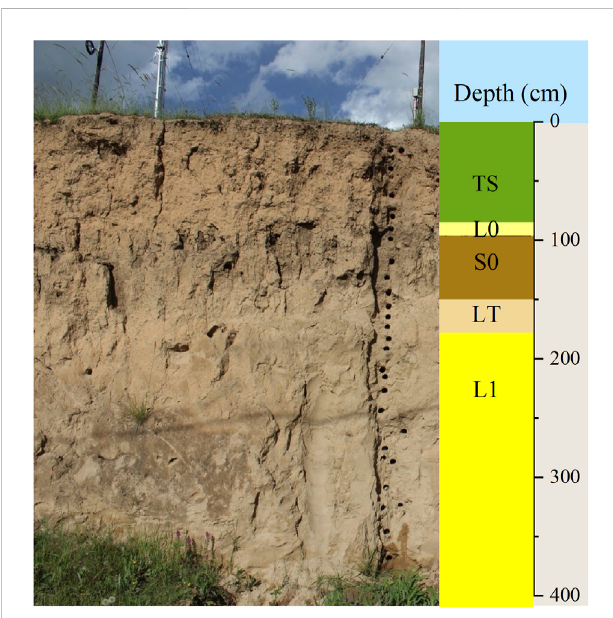
Scheme of the YHC loess-paleosol sequence. The abbreviation of the different layers is explained in Section